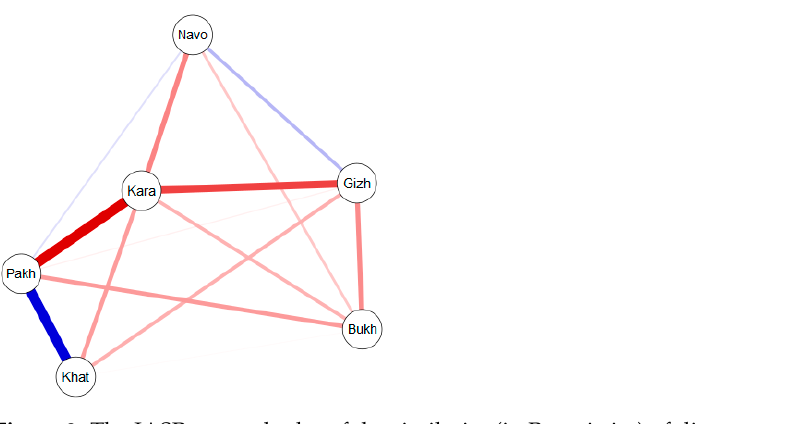
Figure 5. Distribution of bioindicators of salinity preferences, organic pollution according to Watanabe, nutrition type, and trophic state in the Zarafshan River, 2009–2015. Abbreviation for indicator groups: ( a ), Water salinity (Sal): hb, halo- phobe; i, oligohalobious-indifferent; hl, oligohalobious-halophilous; mh, mesohalobious. ( b ), Organic pollution, Watanabe (D): sx, saproxenes, es, eurysaprobes; sp, saprophiles. ( c ), Nutrition type as Nitrogen uptake metabolism (Aut-Het): ats, nitrogen-autotrophic taxa, tolerating very small concentrations of organically bound nitrogen; ate, nitrogen-autotrophic taxa, tolerating elevated concentrations of organically bound nitrogen; hne, facultatively nitrogen-heterotrophic taxa,